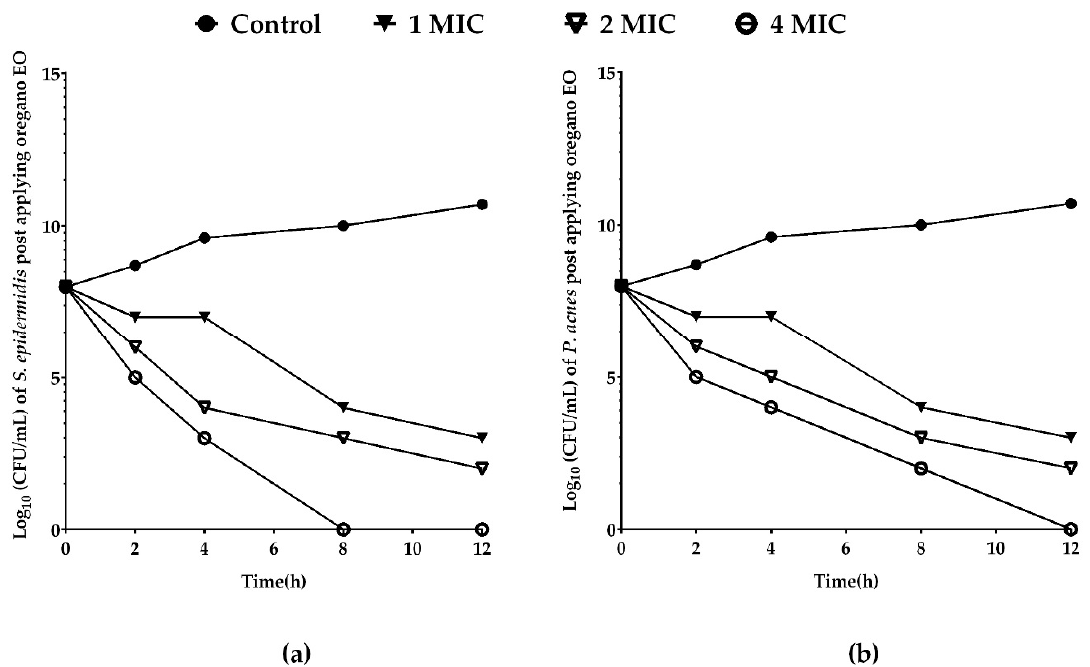
Figure 2. Oregano EO inhibited the growth of S. epidermidis faster than P. acnes . Oregano EO at concentrations of 0.672, 1.34, 2.68 mg/mL (1, 2, 4 MIC) and no EO control was used for assaying the killing rate of bacterial cells at 0, 2, 4, 8 and 12 h and expressed as the surviving bacteria (log 10 CFU/mL) at different exposure times. We used starting bacterial suspension concentration 10 8 CFU/mL. Oregano EO killing rate against ( a ) S. epidermidis and ( b ) P. acnes.